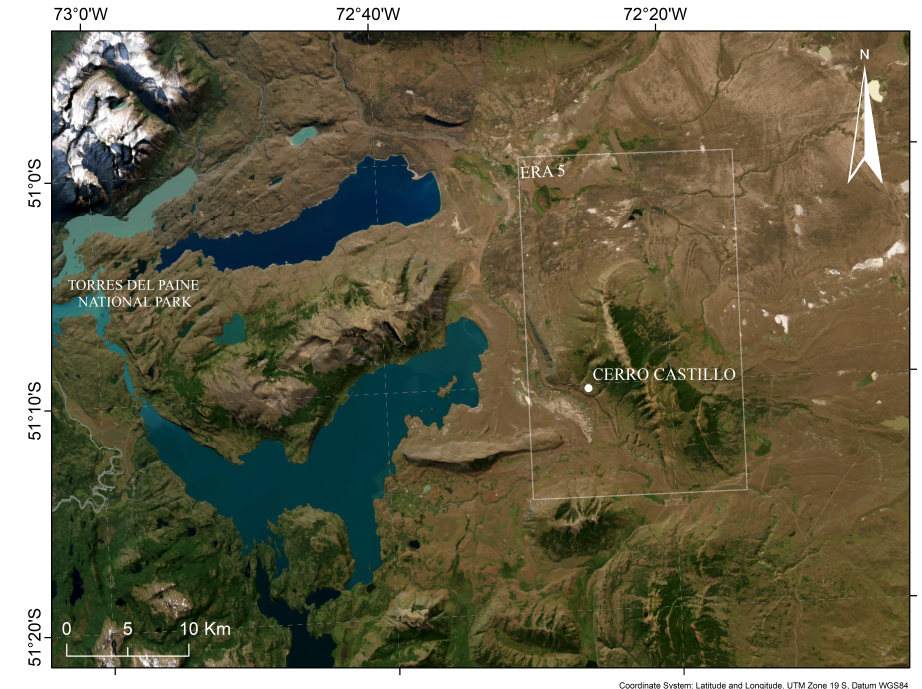
Figure 1. Map of the study area showing the location of the Cerro Castillo meteorological station (white circle) and the corresponding grid (white rectangle) of the ERA5 reanalysis.